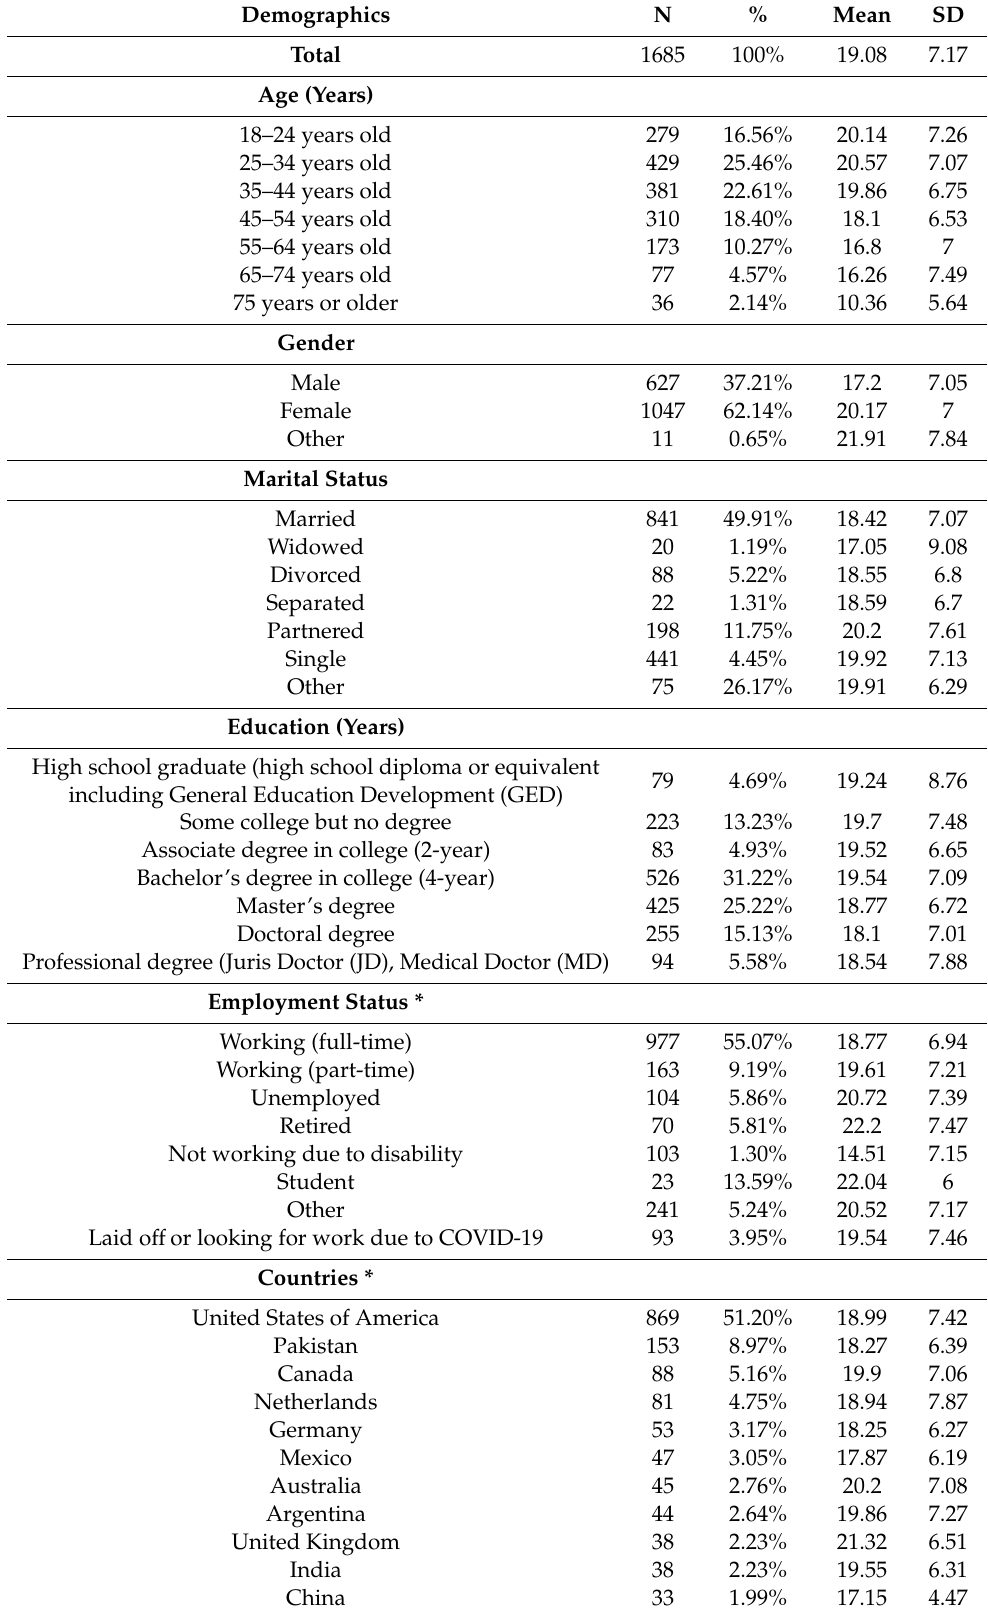
Table 1. Demographics for Global Perceived Stress Scale